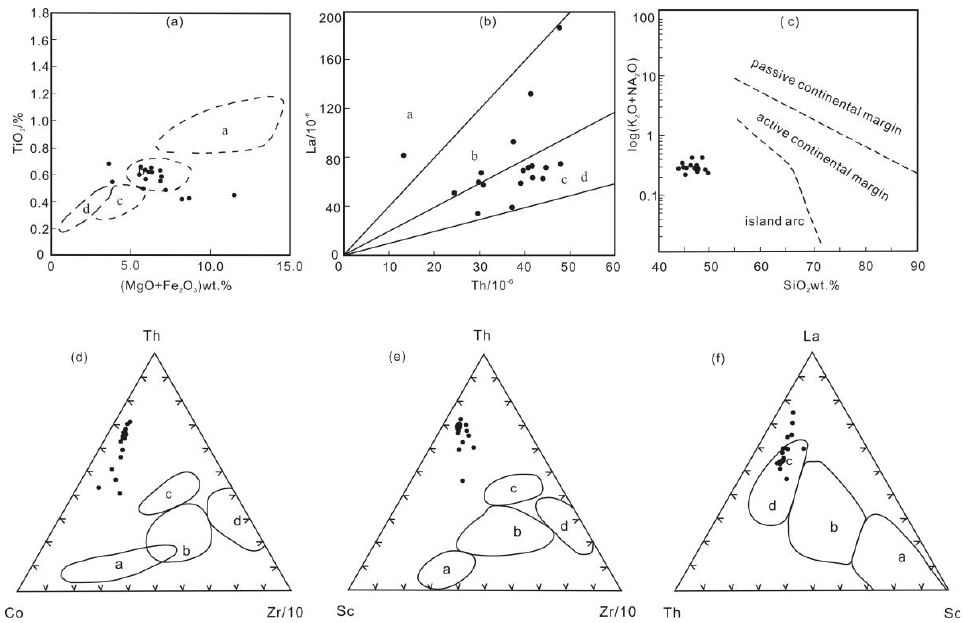
Figure 12. Kinds of discrimination diagrams reflect the tectonic setting. The templates from ( a ) Allegre and Minster, 1978; ( b ) Flord and Leveridge, 1987; ( c ) Roser and Korsch, 1988; ( d ) Bhatia and Crook, 1986; ( e ) Mclennan, 2001; and ( f ) Bhatia, 1985. Maoming Basin, as a part of the Meso-Cenozoic volcanic belt around the Pacific Ocean, had intense magmatic activity in the late Cretaceous but became calm since the Cenozoic. The Maoming Basin belongs to the Wuchuan-Sihui volcanic eruption belt in western Guangdong. In the Late Cretaceous, a large area of a lava flow or banded distri- bution of intermediate-acid extrusive rocks was formed, mainly located southwest of the Maoming Basin. This set of intermediate-acid volcanic rocks has the tectonic setting of a continental island arc, and its formation is related to the subduction of the proto-South China Sea plate to the South China block in the Late Cretaceous [41,94,95]. At present, the intermediate-acid volcanic rocks southwest of the basin are most likely the parent rocks of the oil shale deposits of the Paleogene Youganwo Formation in the Maoming Basin, which is consistent with the felsic volcanic rocks in the continental island arc tectonic set- ting. However, the transition between the Late Cretaceous volcanic and the Paleogene clastic rocks in the basin may also represent the transition from the active continental mar- gin of the proto-South China Sea to the modern passive continental margin of the South China Sea [94]. 6. Conclusions 1. The comprehensive test results show that the oil shale in Maoming Basin is of me- dium quality with high ash content, high calorific value, and ultra-low sulfur. The oil shale is in an immature stage, and the organic matter type is I-II1, with excellent hydrocarbon generation potential. 2. The chemical index of alteration (CIA), the index of chemical variability (ICV), and the Th/U ratio indicate that the parent rock area of Maoming oil shale is strongly weath- ered.